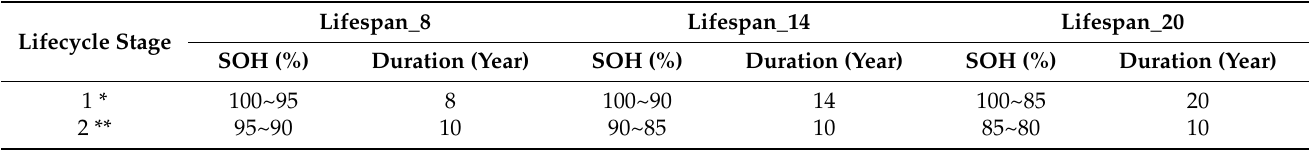
Table 1. Three scenarios for LIB lifespan at each lifecycle